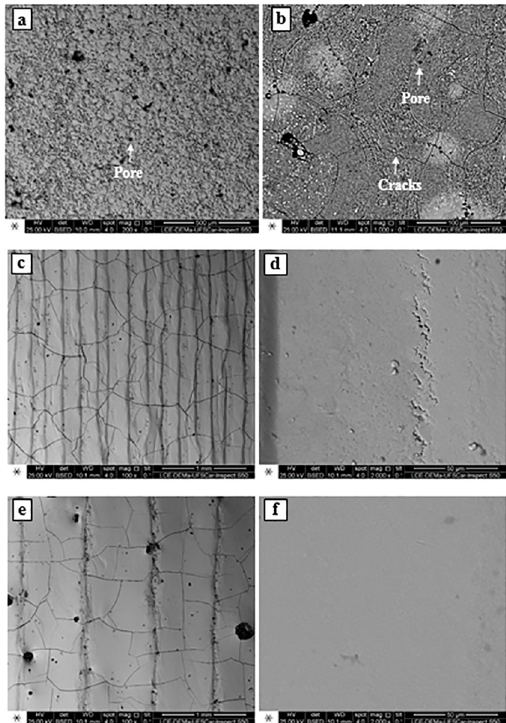
Cr Nb B 60 8 8 24 Figure 4. Average Vickers microhardness of the Fe coatings surface produced by (a) LC with different overlaps, 66%, 53% and 44%, and layers by (b) LSR without LASER application and after LSR process with several processing parameters and overlap values shown in the Table